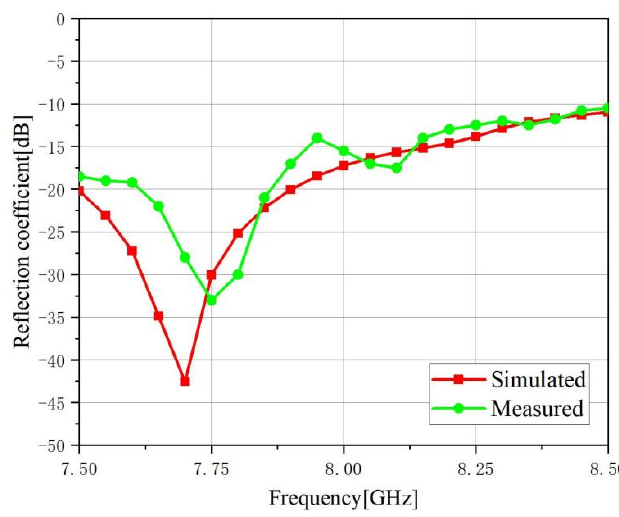
Figure 13. The reflection coefficients of the HPM antenna unit.